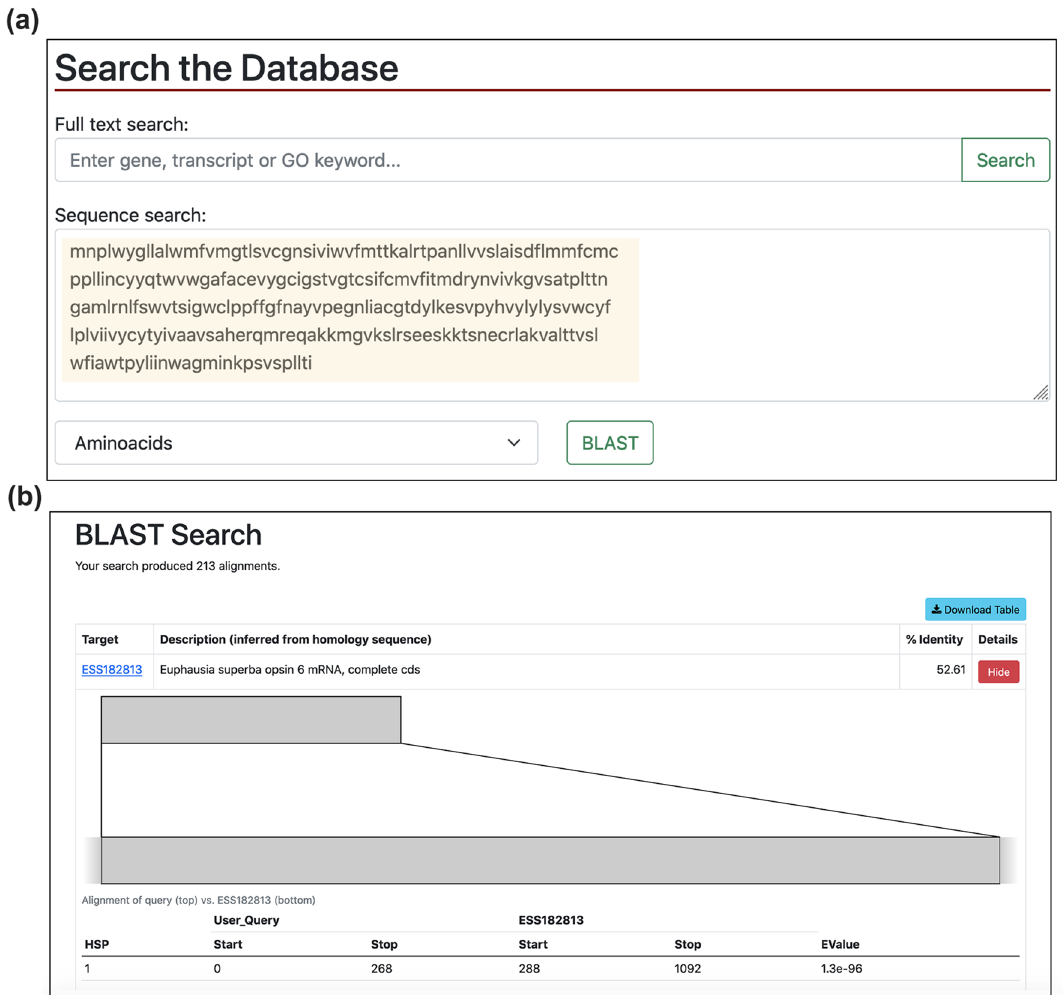
Figure 3. Blast search section. The new search box for sequence searches ( a ) with an example of a BLAST search (highlighted in yellow) and the corresponding results ( b ). By clicking on each target identifier, the user will be redirected to that specific transcript page, where new sections have been added, as shown in Fig.